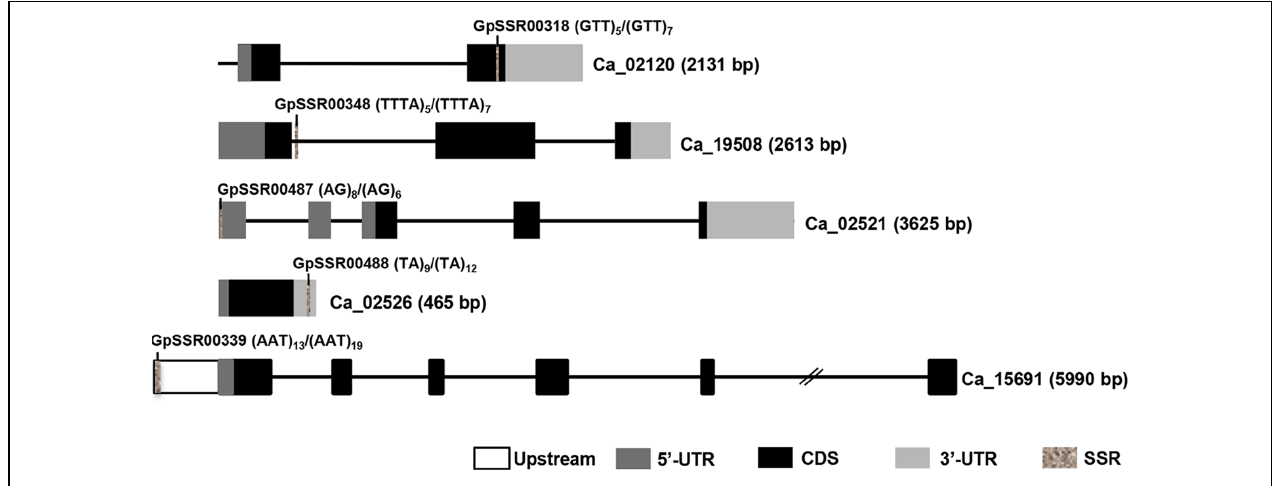
FIGURE 4 | Diagrammatic representation of polymorphic SSRs present in different components of chickpea genes. Introns and exons are represented by lines and boxes, respectively. Different components of exons are represented in different shaded boxes. The